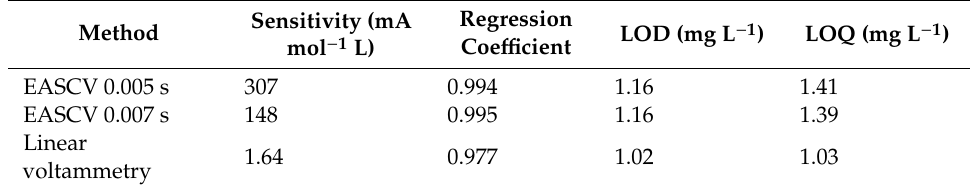
Table 1. Performances of the analytical methods after electrodeposition of lead at − 0.5 V/SCE for 90 s on gold electrode without stirring.